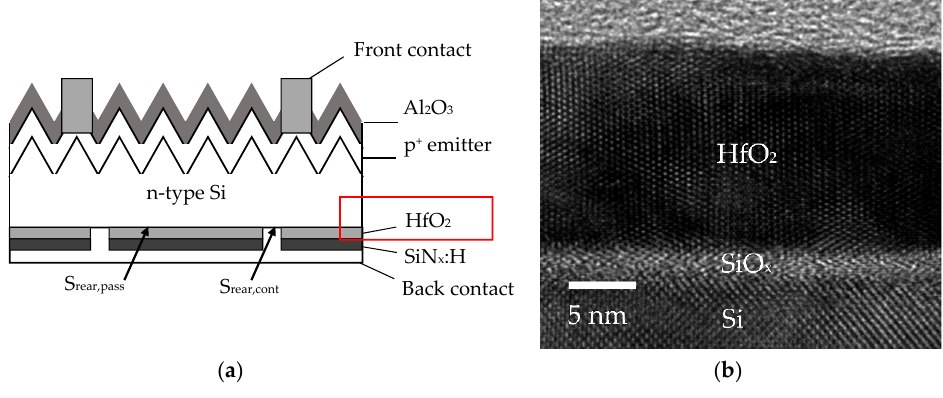
Figure 2. ( a ) n-type passivated emitter and rear contact (PERC) cell structure; ( b ) transmission electron microscopy (TEM) image of the HfO 2 /Si interface annealed at 550 °C.